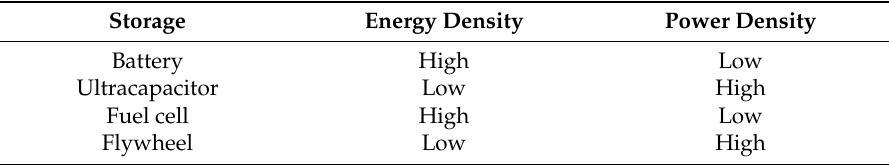
Table 13. Relative energy and power densities of different energy storage systems [63].